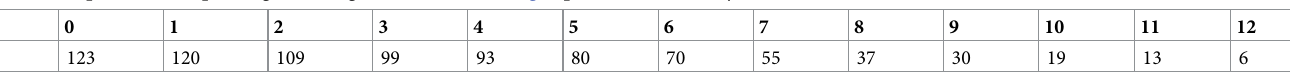
Table 1. Sample size corresponding to the Vigie-Nature curve in Fig 1 (points from 0 to 12